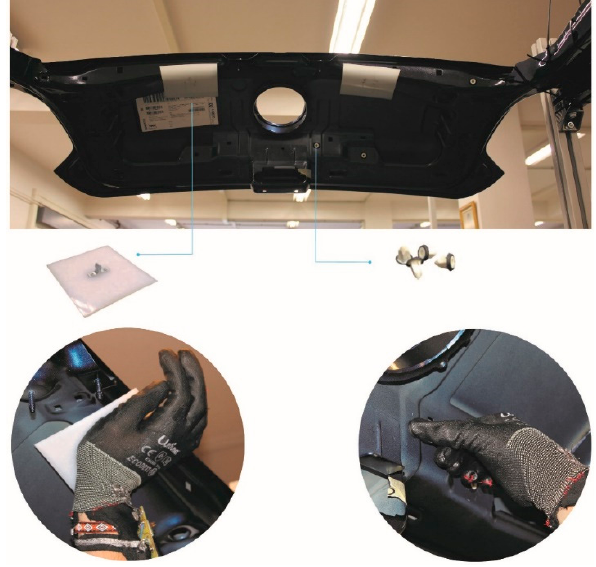
Figure 11. Prototype testing in a real rear door.